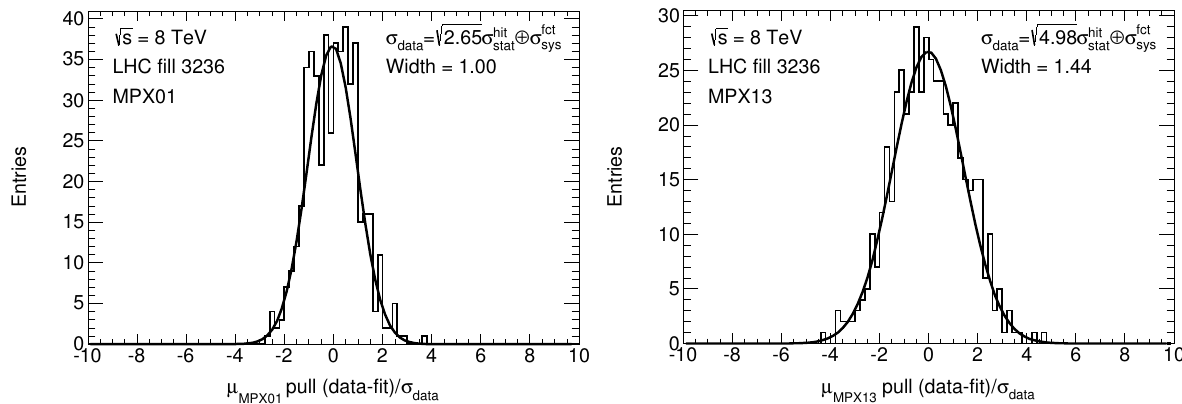
√ ⊕ σ fct = N R · σ hit hit / N cl is determined sys . The ratio R stat